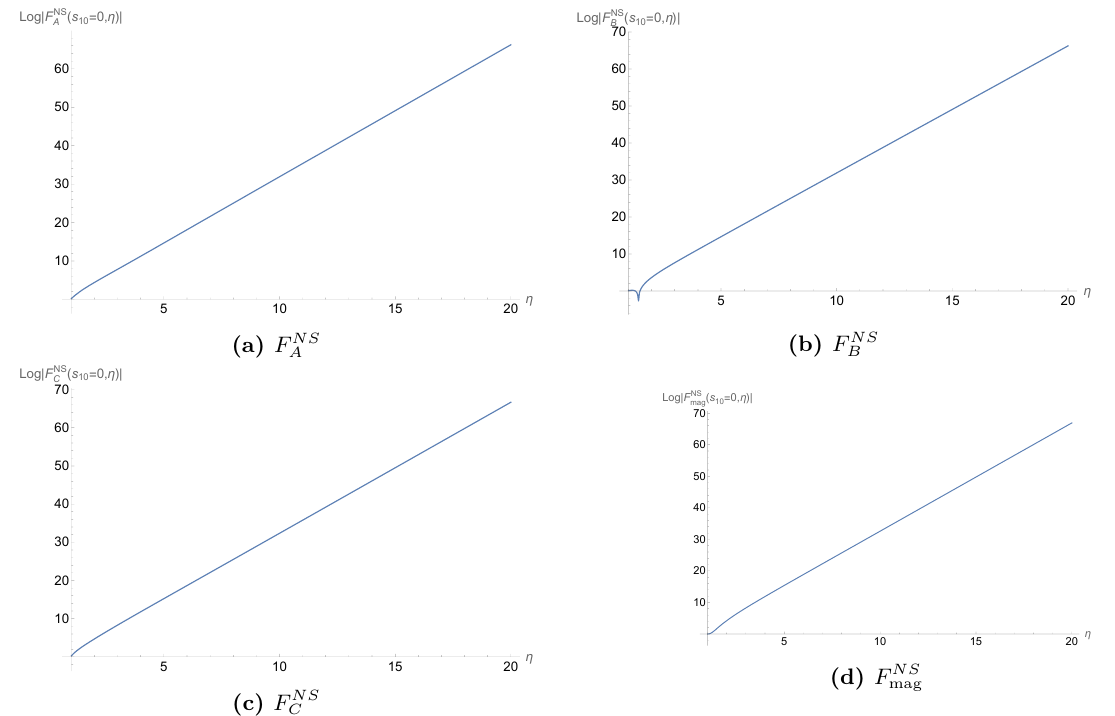
Figure 3. Plots of our numerical solutions for the dipole amplitudes numerically calculated at η max = 20 and ∆ η = ∆ s = η max /N = 0 . 033 . The plots depict the logarithm of the absolute value of each dipole amplitude as a function of the single variable η along the line s 10 = 0